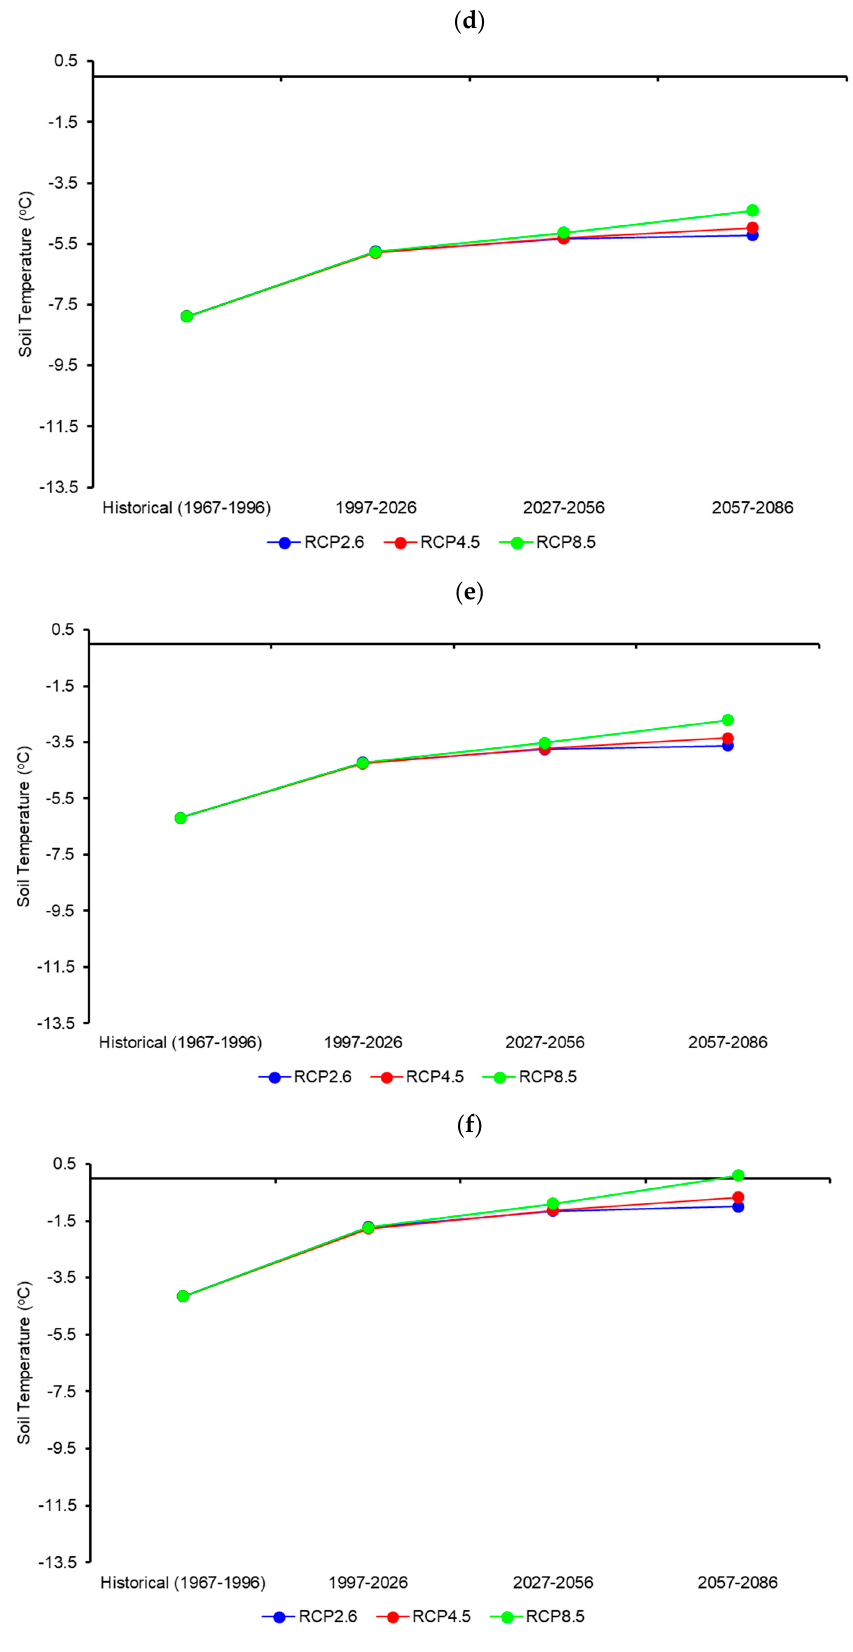
Figure 10. Winter soil temperature projections from 1997 to 2086 for depths at: ( a ) 5 cm; ( b ) 10 cm;